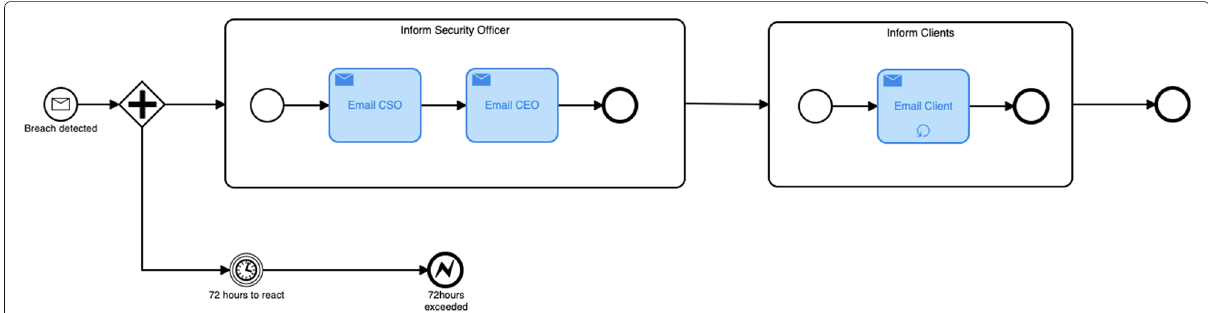
Fig. 9 Process triggered when data leak detected